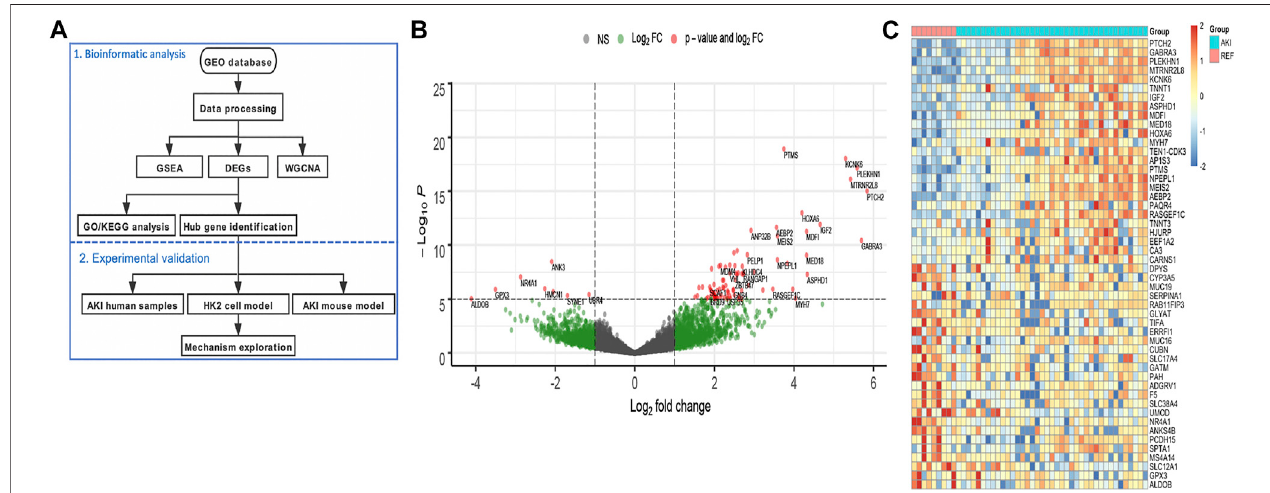
FIGURE 1 | Identi fi cation of the differentially expressed genes in AKI patients. (A) Flowchart of the bioinformatic analysis and experimental validation. (B) Volcano plot of the DEGs between AKI and REF. (C) Heat-map of the top upregulated and downregulated 50 DEGs from AKI and REF transcriptome pro fi